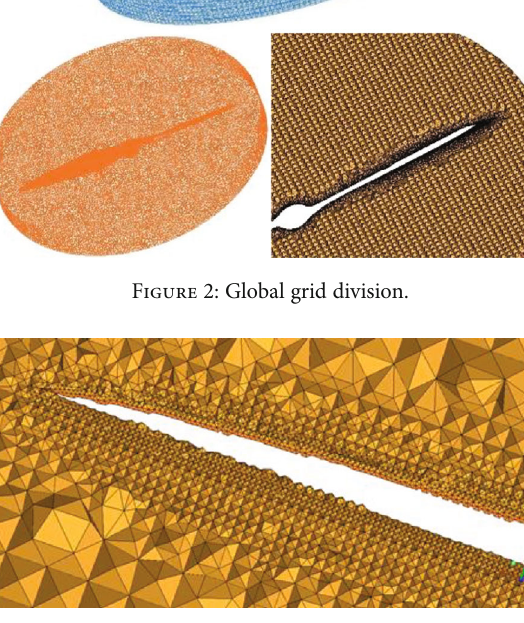
Figure 3: Boundary layer grid around the blade.